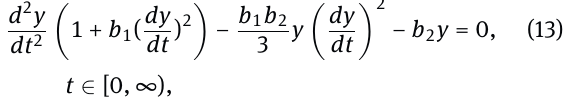
Fig. 2: Obtained graphs of unsteady gas equation for β = 0.25, 0.50,